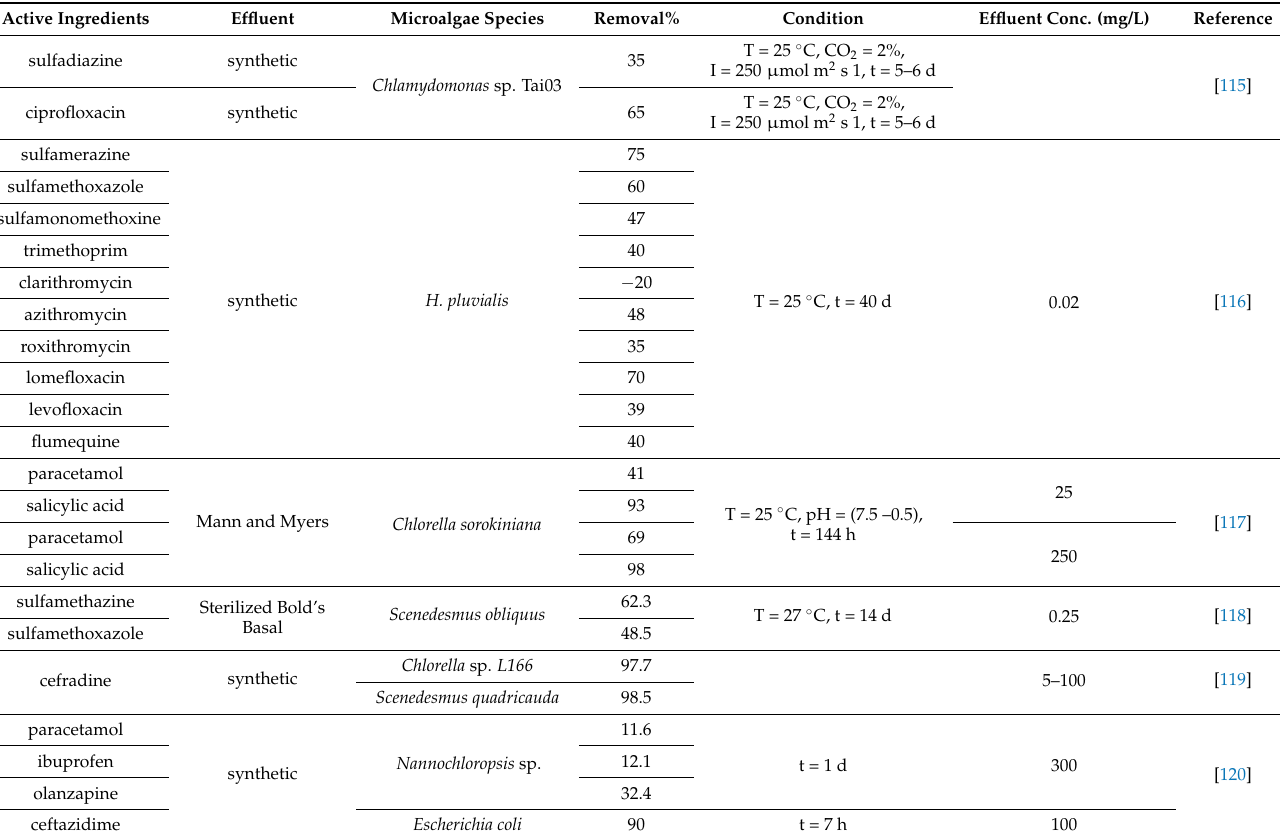
Table 6. Emerging Pollutant Removal using